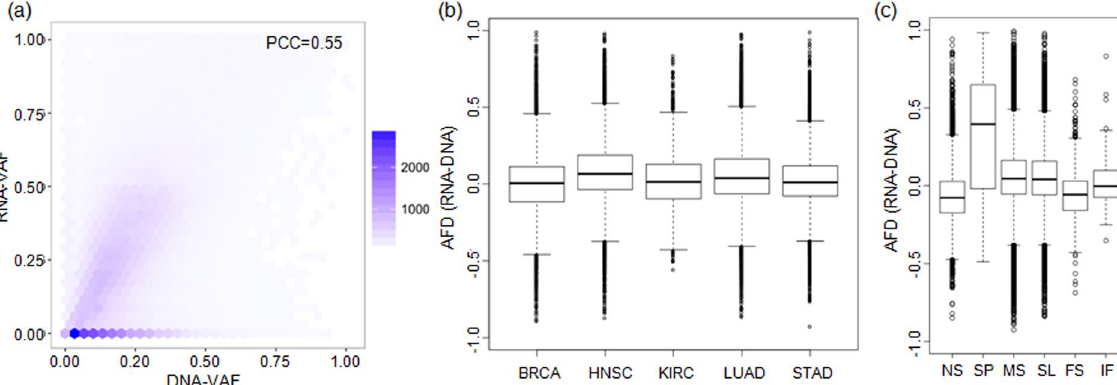
Figure 1. VAF and somatic mutations. ( a ) VAF of individual mutations observed in WES and RNA-seq are shown in x - and y -axis, respectively. The number of points or mutations is represented by the color density. PCC is Pearson correlation coefficient ( P value was not shown because it was negligible). ( b , c ) Boxplots of AFD are shown for five tumor types ( b ) and for six mutation categories ( c ). NS, nonsense mutations; SP, splice site mutations; MS, missense mutations; SL, silent mutations; FS, frameshift indels; IF, inframe